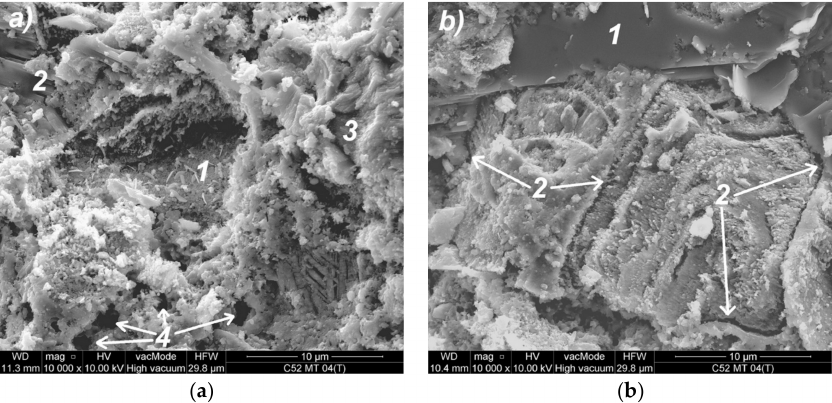
Figure 11. SEM photos of the C52MT cement paste microstructure: ( a ) magnification 10,000 × ; ( b ) magnification 10,000 × —another area; descriptions of the indications in the